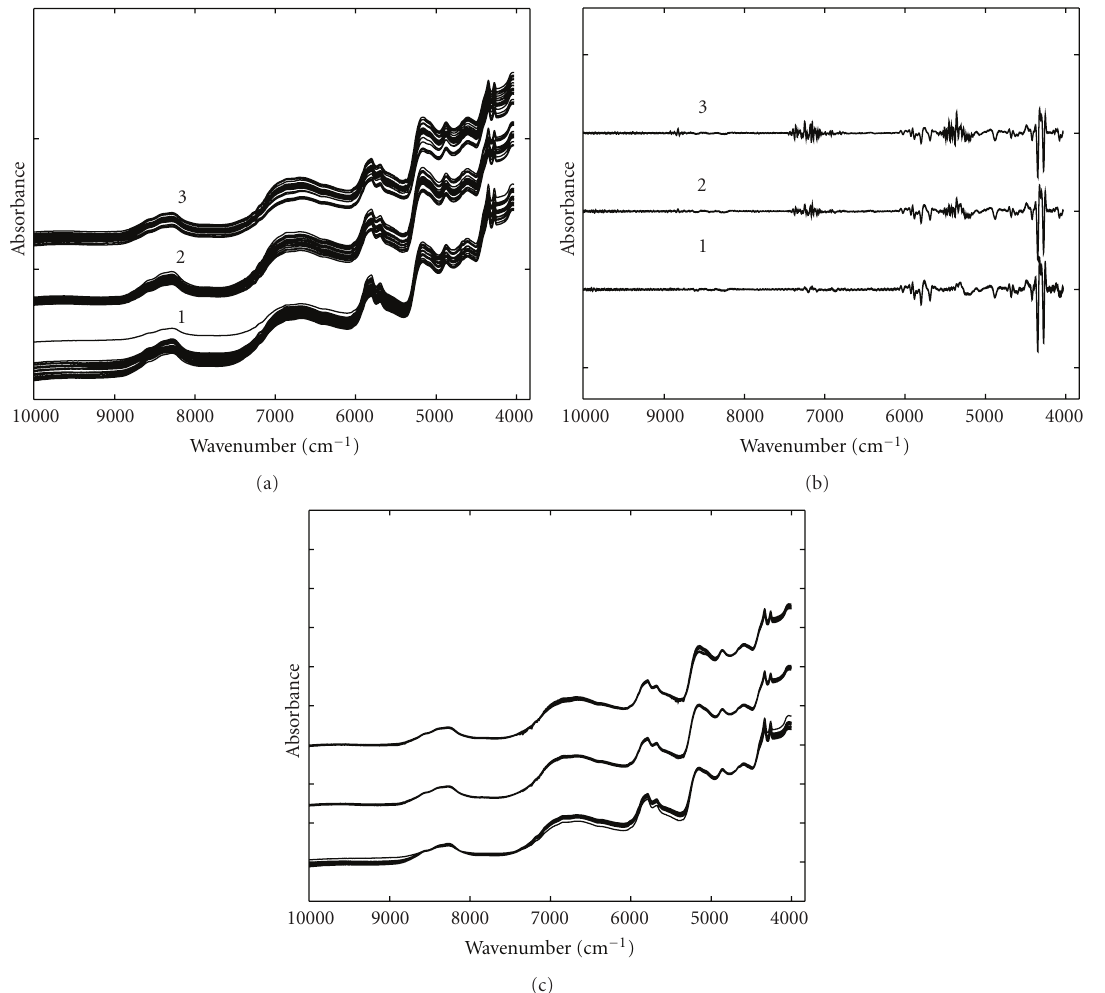
Figure 3: Some of the NIR spectra of cotton seeds preprocessed by (a) smoothing, (b) second-order derivative, and (c) SNV. The genotypes were (1) parent 222, (2) transgenic 07-19, and (3) hybrid 08-6.